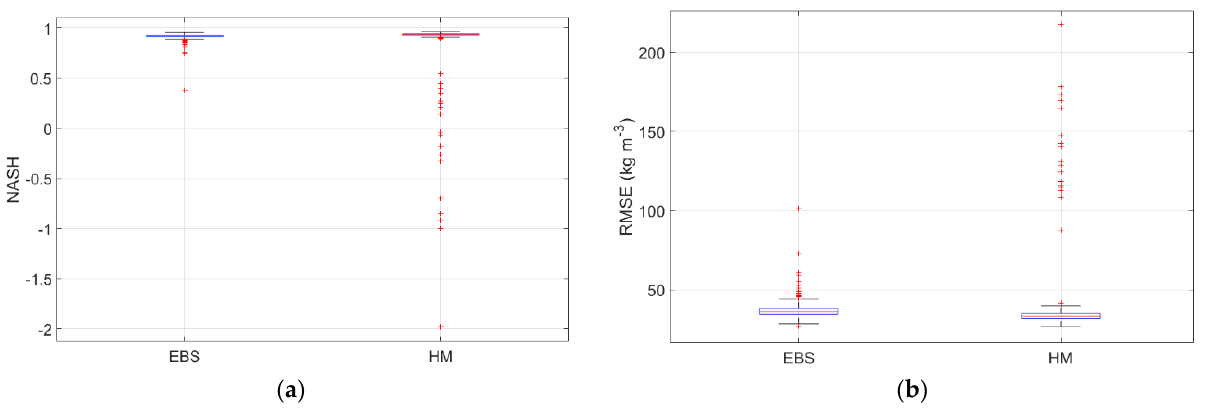
Figure 9. Boxplots representing the distribution of estimated snow density values expressed in ( a ) NASH and ( b ) RMSE, according to the two models EBS and HM. ( a ) NASH and ( b ) RMSE, according to the two models EBS and